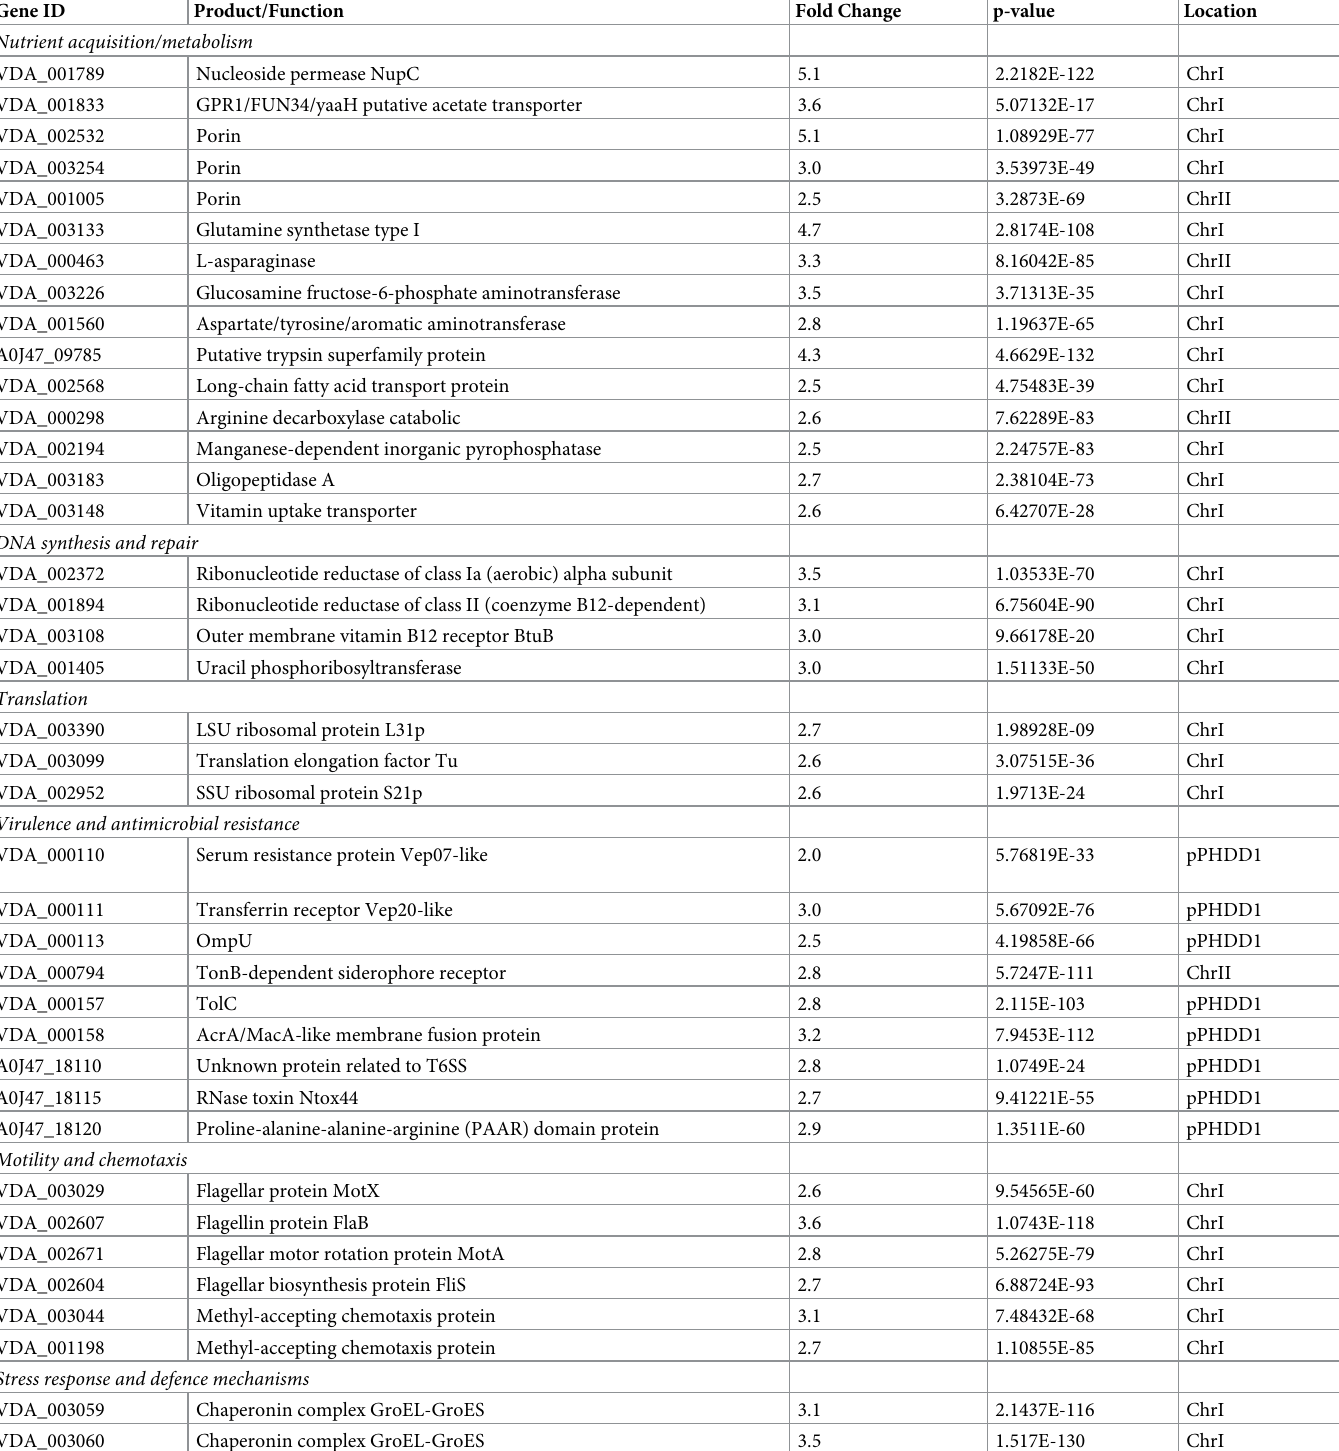
Table 1. List of selected DEGs with enhanced expression at 25˚C including the 50 top upregulated genes at 25˚C. Enhanced expression at 25˚C is denoted by positive FC values. Genes with VDA codes correspond to the annotation in the CIP102761 genome, and genes with A0J47 codes correspond to the annotation in the RM-71